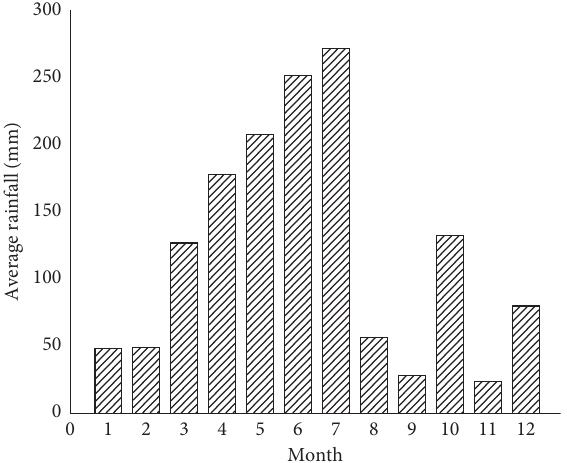
Figure 1: The average rainfall of the Longlang Expressway from 2015 to 2019.